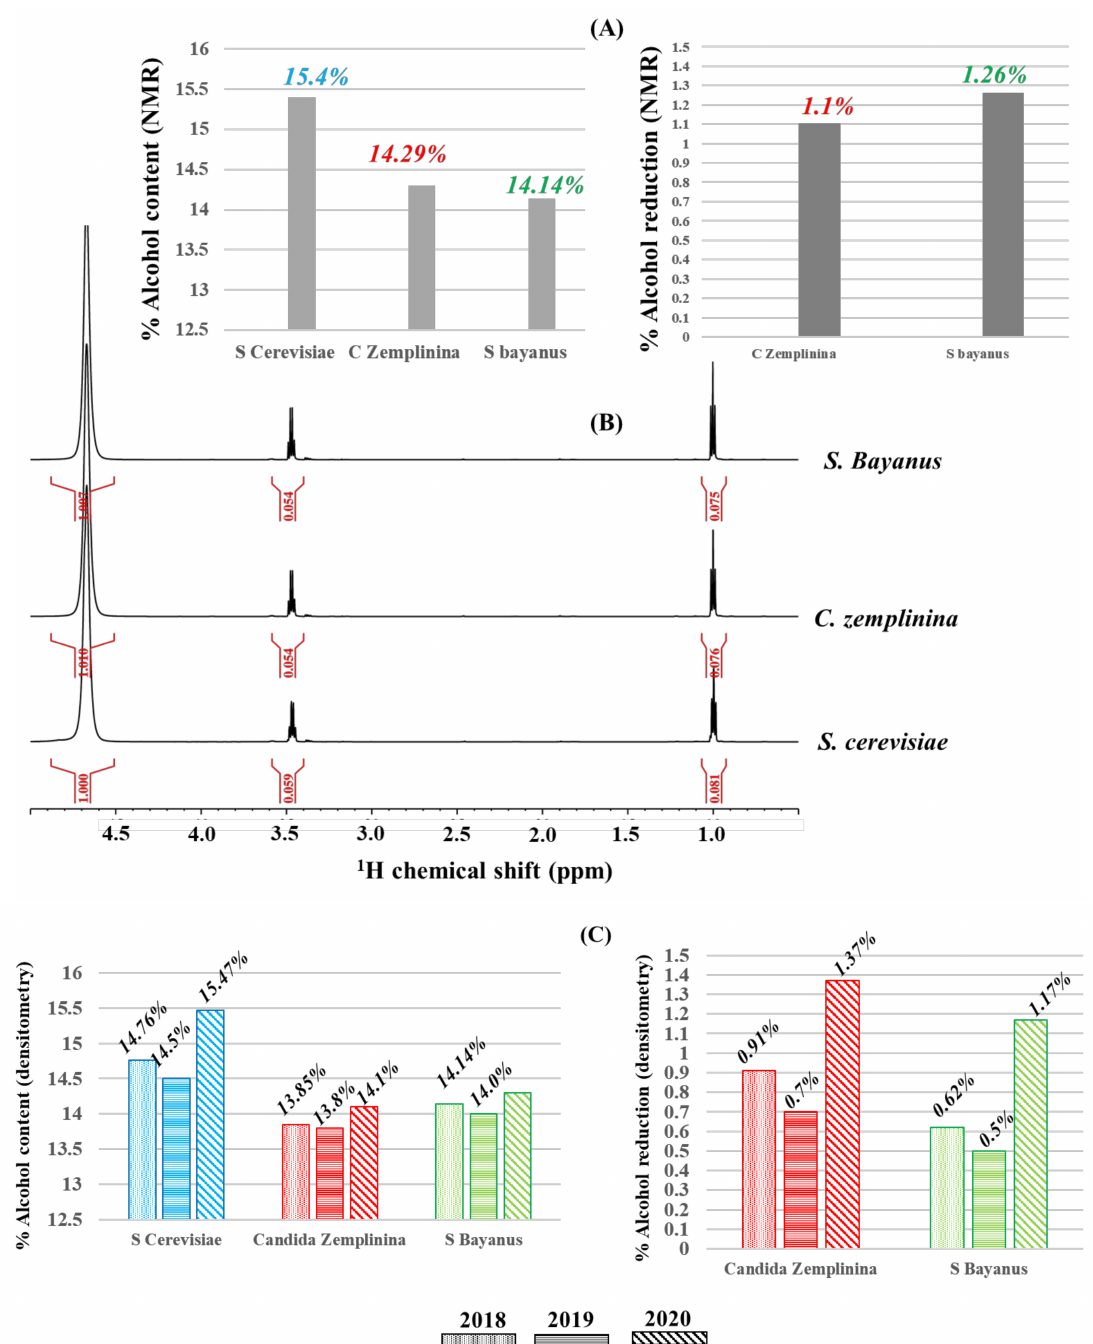
Figure 1. ( A ) The %Alcohol content of Cabernet Sauvignon wine samples, all fermented at a large-scale regime (1950 L produced from c.a. 3000-Kg raw grapes) from the latest 2020 harvest with a standard Saccharomyces cerevisiae , co-inoculation with Candida zemplinina , and inoculation with Saccharomyces Bayanus ex uvarum yeast strains (left). The alcohol reduction with respect to Saccharomyces cerevisiae (right), measured with quantitative proton NMR spectroscopy ( B ), in comparison with the quantified %alcohol content ( C , left) and %alcohol reduction ( C , right) of the same large-scale fermentation wine samples produced from 2018 (dotted histograms), 2019 (horizontally lined histograms), and 2020 (45 ◦ tilted-lined histograms) harvests, all obtained with the standard densitometry